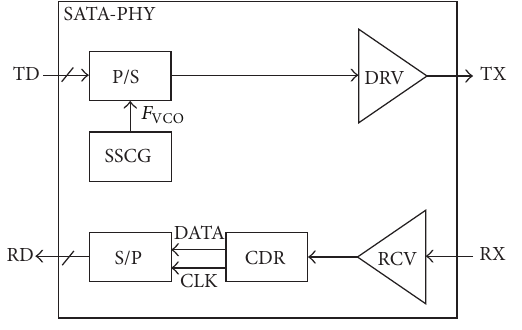
Figure 1: Block diagram of SATA-PHY.